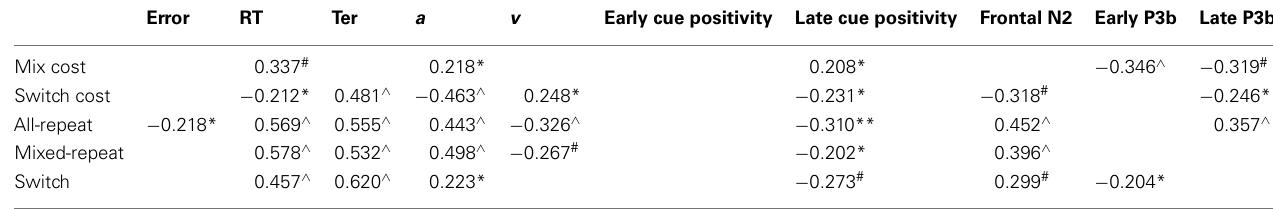
Table 1 | Pearson correlations between age and behavioral, latent and electrophysiological measures of mixing and switch costs, and for all-repeat, mixed-repeat and switch